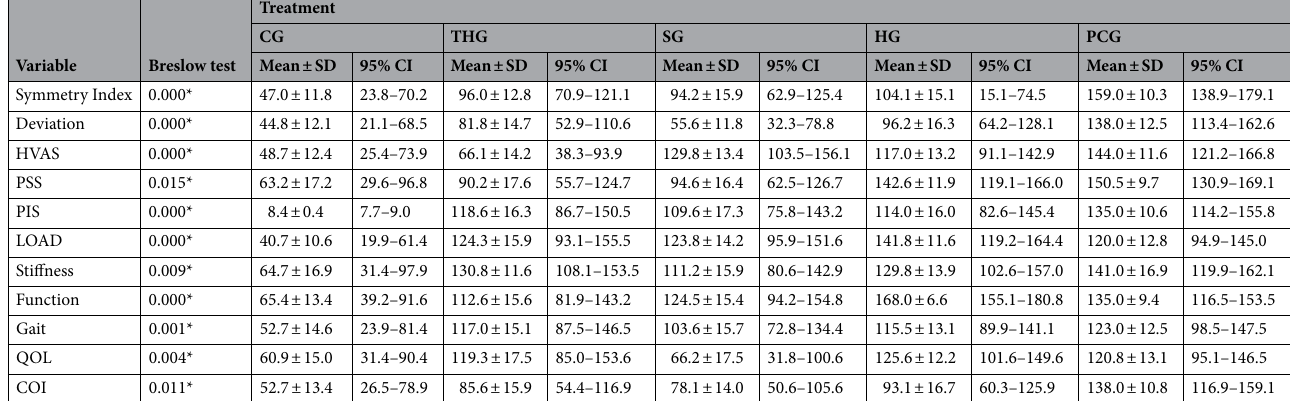
Table 2. Survival probability calculated with Kaplan–Meier estimators and compared with the Breslow test. See Table 1 for legend. *Indicates